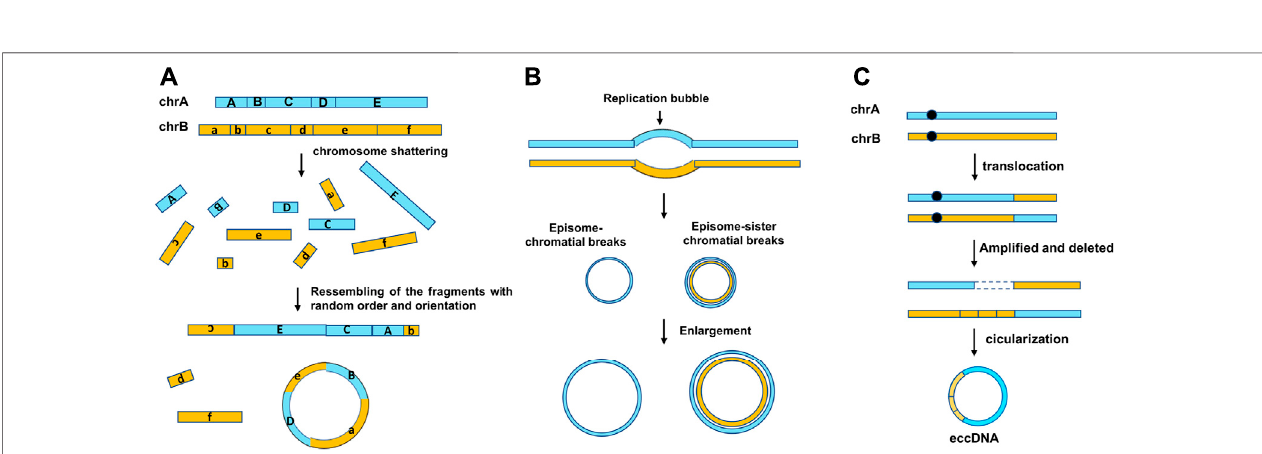
FIGURE2| ThreemechanismsofeccDNAbiogenesis. (A) “ Chromothripsis ” model,chromothripsisisthegenerationofDNAdouble-strandbreaks.Fragmentsare joined together in a random order and orientation by DNA repair machineries. The new chromosomes may contain complex structural rearrangements and structural variants. (B) Episome model, DNA bidirectionally replicates leading to two replication forks, and the region between them is the replication bubble. The replication fork collapse when the error in replication take place, and then, the replication bubbles drop and form shape of an episome. They can enlarge to form eccDNAs by replication and recombination. (C) Translocation – excision – deletion – ampli fi cation model. Gene translocation occurs near the chromosome. The fragment next to the translocation positions can be ampli fi ed, deleted, and circularized, generating the genesis of eccDNA.